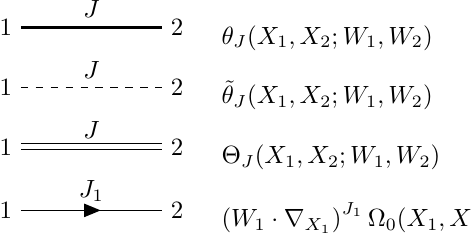
Figure 2 . The line notations for the different bulk bi-local